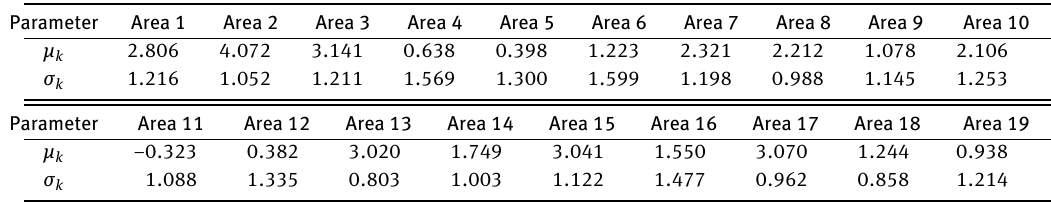
Table 5: Distributional parameters for fitted lognormal loss